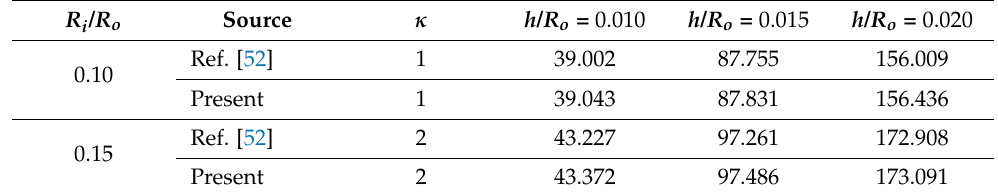
Table 1. Comparison of critical buckling temperature ∆ T cr of isotropic homogeneous annular plates for different values of the inner radius to outer radius ratio R i and thickness to outer radius ratio R o / h ( ν = 0.3, α = 7.4 × 10 − 6 K).